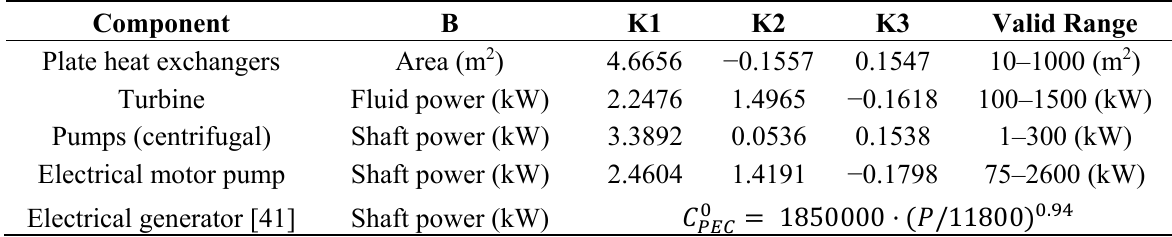
Table 5. Cost parameters [59].